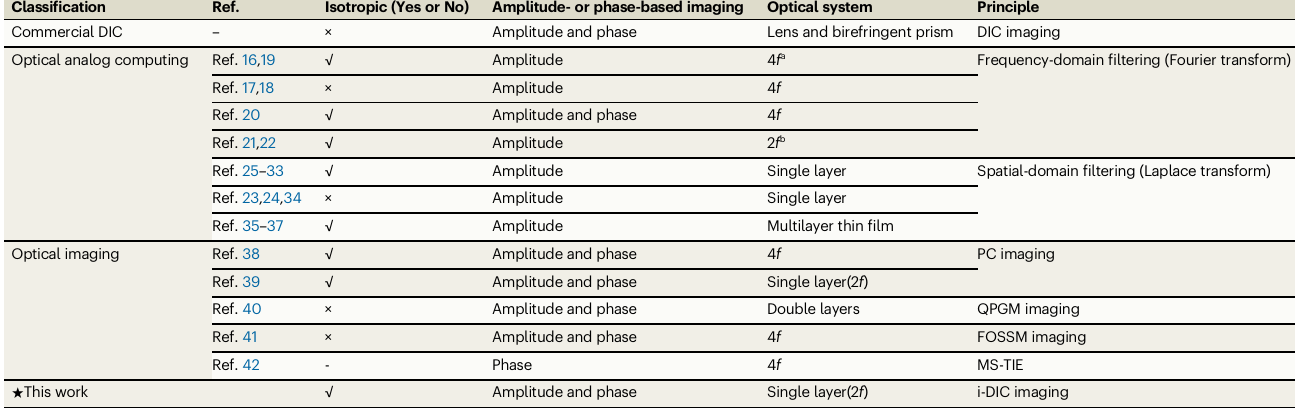
Table 1 | Comparison of commercial DIC, metasurface-based optical analog computing, optical imaging, and our i-DIC system Classi fi cation